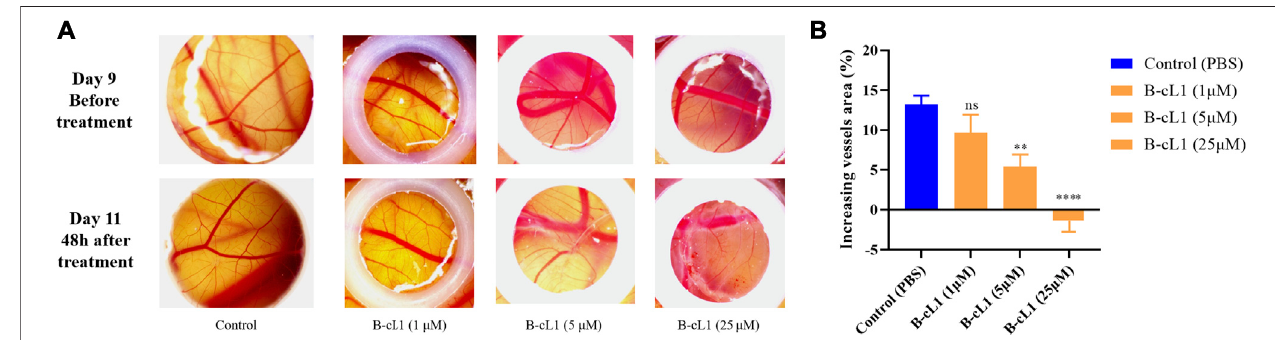
FIGURE 7 | B-cL1 inhibits angiogenesis in CAM model. (A) Representative images of chorioallantoic membrane before and after treatment (48 h) with B-cL1 at 1 μ M, 5and 25 μ M, or withPBS ascontrol. (B) Thepercentage ofcapillaryarea intotal analyzed areawasquanti fi ed with AngioTool (Zudaireet al.,2011),the difference of vessels area (percentage ofcapillaryarea at T48h -percentage ofcapillaryarea at T0h) was analyzed using GraphPad Prism 8.Dataarepresented asmean ± SEMof three experiments, compared to the control group in one-way ANOVA statistical analysis. ** p < 0.01, **** p < 0.0001, “ ns ” meaning non-signi fi